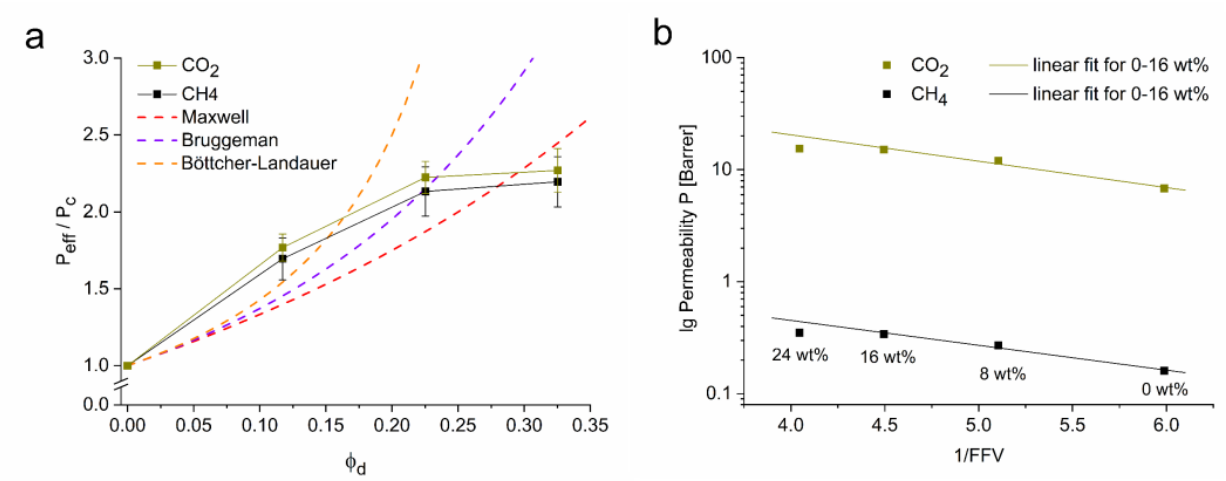
Figure 3. P eff / P c versus φ d for 0 wt%, 8 wt%, 16 wt%, and 24 wt% CTF-biphenyl/Matrimid ® MMMs in comparison to the Maxwell, Bruggeman, and Böttcher–Landauer model for porous fillers ( a ) and logarithm of permeability P versus 1/FFV for 0 wt%, 8 wt%, 16 wt%, and 24 wt% for CTF-biphenyl/Matrimid ® (right) MMMs ( b ).